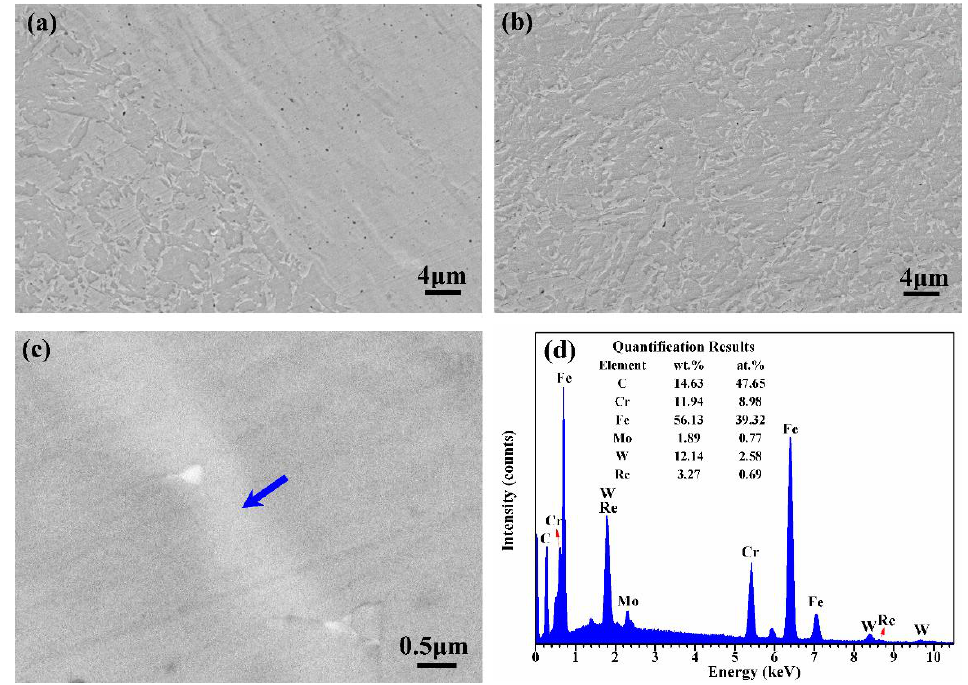
Figure 5. SEM micrographs of ( a ) TMAZ/SZ-AS; ( b ) TMAZ/SZ-RS; ( c ) magnified band structure from ( a ) and ( d ) its corresponding EDS analysis.